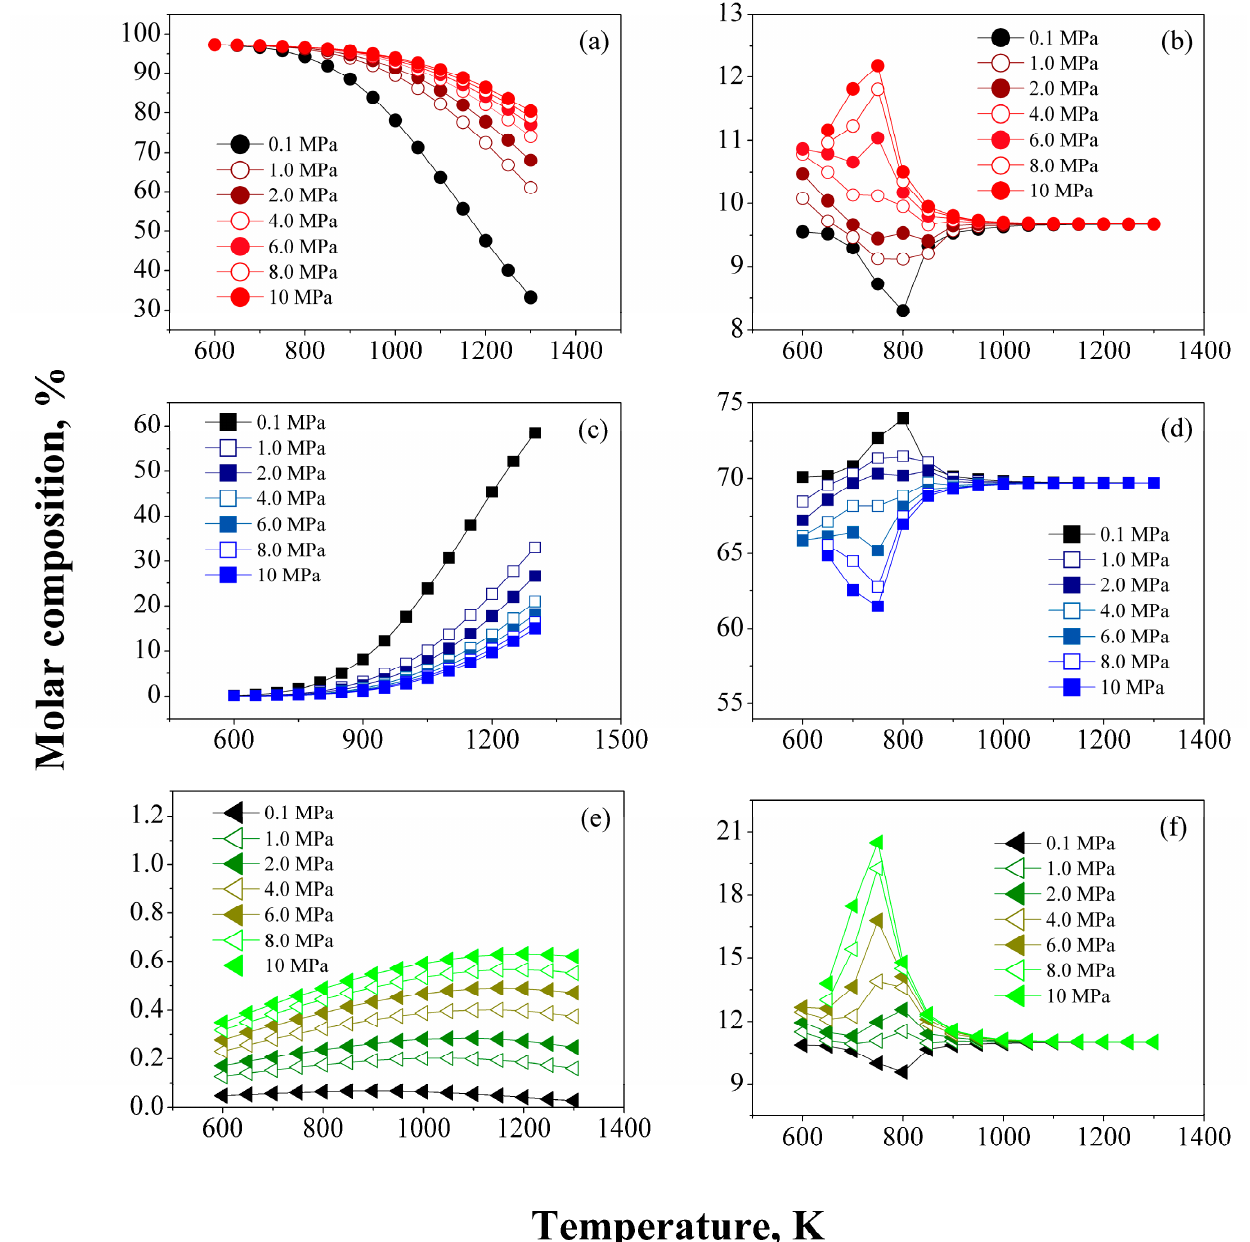
Figure 3. Effect of pressure on gas products: ( a ), ( c ), ( e ) Equilibrium. ( b ), ( d ), ( f ) Catalytic. ( / ) CH 4 , ( / ) H 2 , ( / ) C 2 –C 5 .